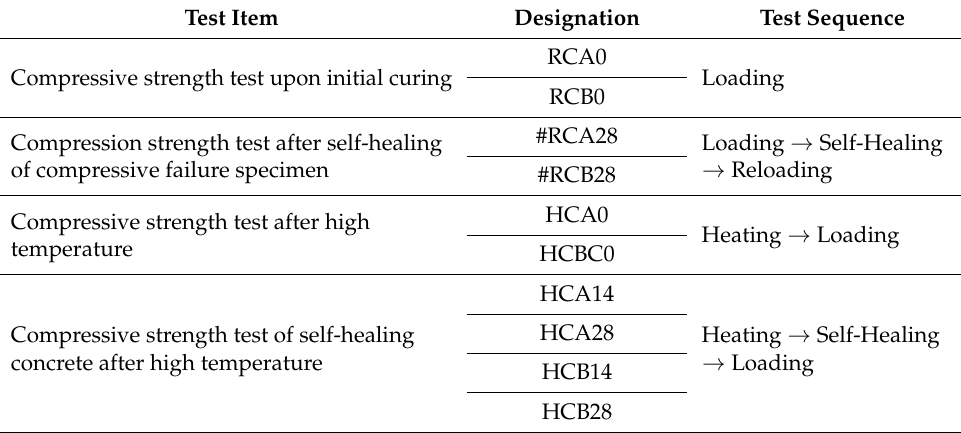
Table 3. Compression test items and test sequence.